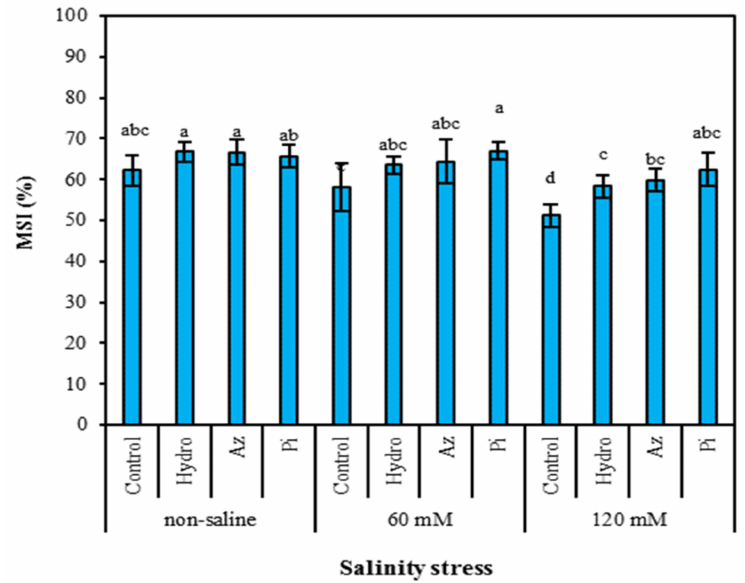
Figure 2. Effect of seed priming on membrane stability index (MSI) of milk thistle leaves under different levels of salinity. The same letter within each column indicates no significant difference among treatments ( p ≤ 0.05) using New Duncan’s test. Values mean of four replicates ± SD. Hydro: hydro-priming, Az: Azotobacter chroococcum and Pi: Piriformospora indica